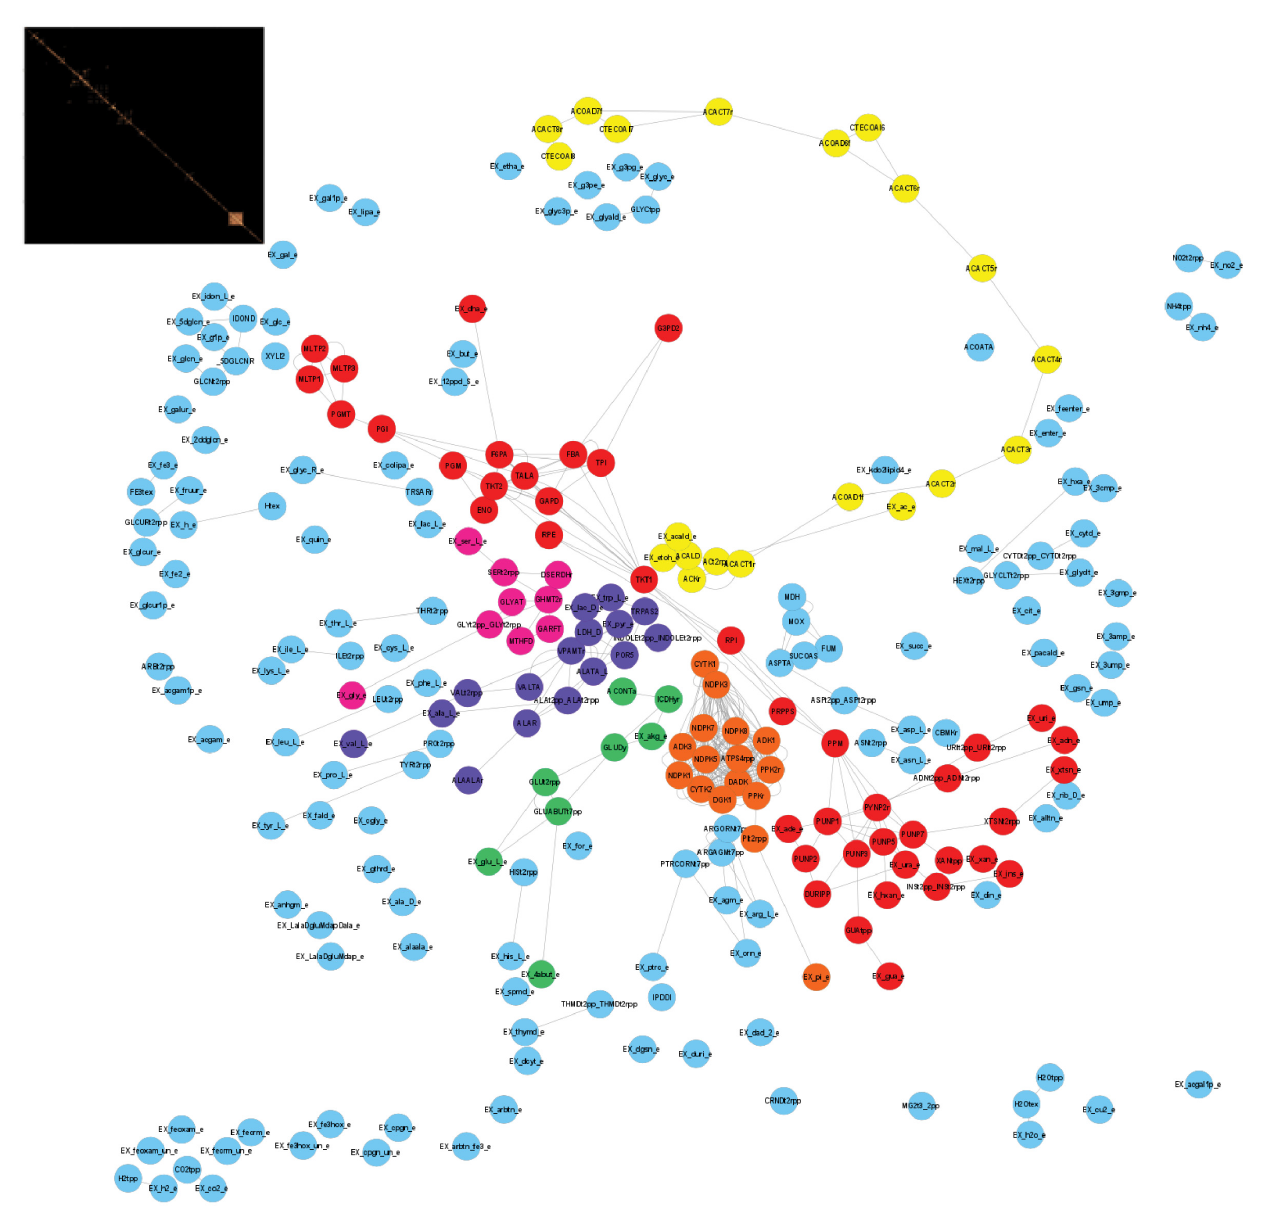
Fig 1. Modules of structural reversible reactions of iJO1366. The network was subdivided into modules of reversible reactions that share metabolites. Each node represents a reversible reaction and each edge a metabolite connecting two reversible reactions. The topology of the network is given by the invisible presence of irreversible reactions that connect the reversible reactions. The six largest modules that contain more than seven reversible reactions: TCA cycle (green), Fatty acids metabolism (yellow), Glycolysis, PPP, ribonucleotides and sugars metabolism (red), Pyruvate metabolism (purple), Folate, serine and glycine metabolism (pink), and Nucleotides metabolism (orange). Insert left corner shows the reaction adjacency matrix of the structural reversible reactions, which also represents the reversible reaction modules. correlation between distance-2 reactions belonging to different modules was generally low with only 0.4% displaying absolute correlation values greater than 0.8 and 25% showing less than 0.1 absolute correlation value (Fig B in S1 Fig). In contrast, more than 37% of intra-mod- ule distance-2 reactions displayed an absolute correlation value greater than 0.8 and only 12%